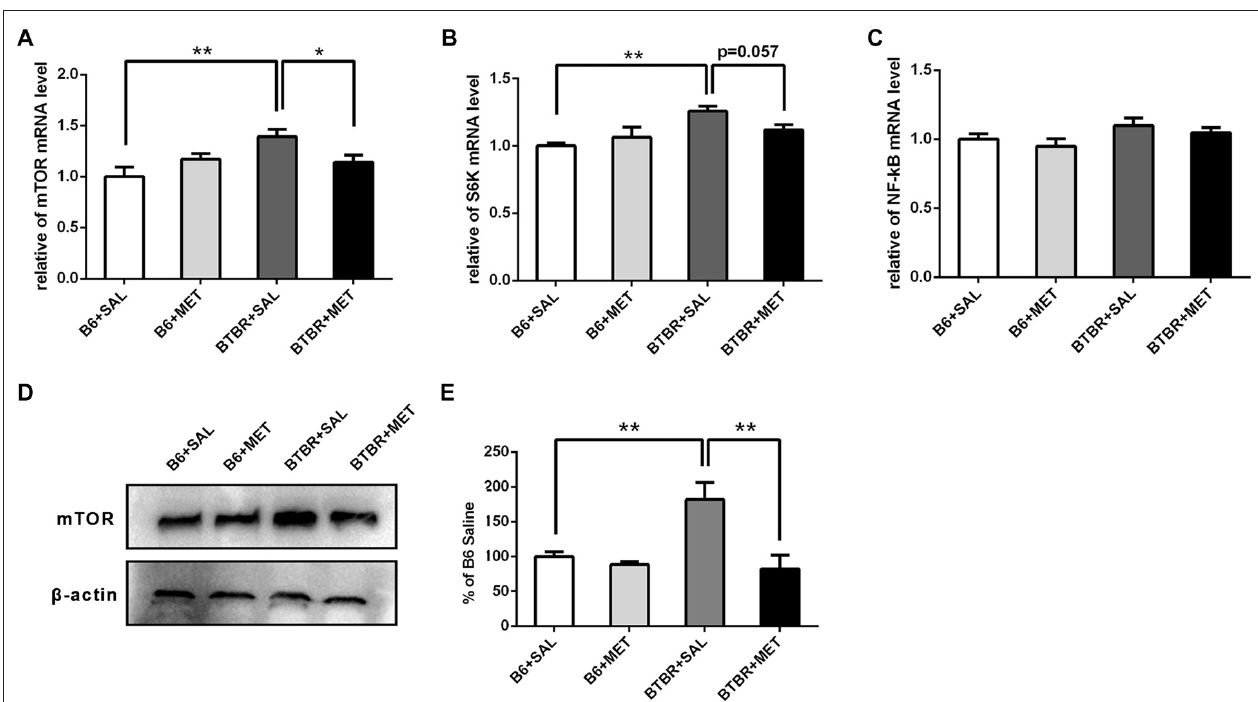
FIGURE 7 | Expression of mTOR, S6K, NF- κ B and the protein levels of mTOR in the cerebral cortex of B6 and BTBR mice. (A) BTBR mice showed an increased expression of mTOR in the cerebral cortex, and metformin treatment could decrease mTOR mRNA level in BTBR mice. (B) BTBR mice showed an increased expression of S6K in the cerebral cortex, and a decreased trend of S6K level was seen after metformin treatment. (C) The expression of NF- κ B was not affected by the metformin treatment. Data are presented as the means ± SEM. n = 4. ∗∗ P < 0.01, ∗ P < 0.05. (D) Representative western blot image for mTOR protein expression. (E) Quantitative data of mTOR protein expression in the cortex of the mice. Data are expressed as the means ± SEM ( n = 3 in each group; ∗∗ P < 0.01).